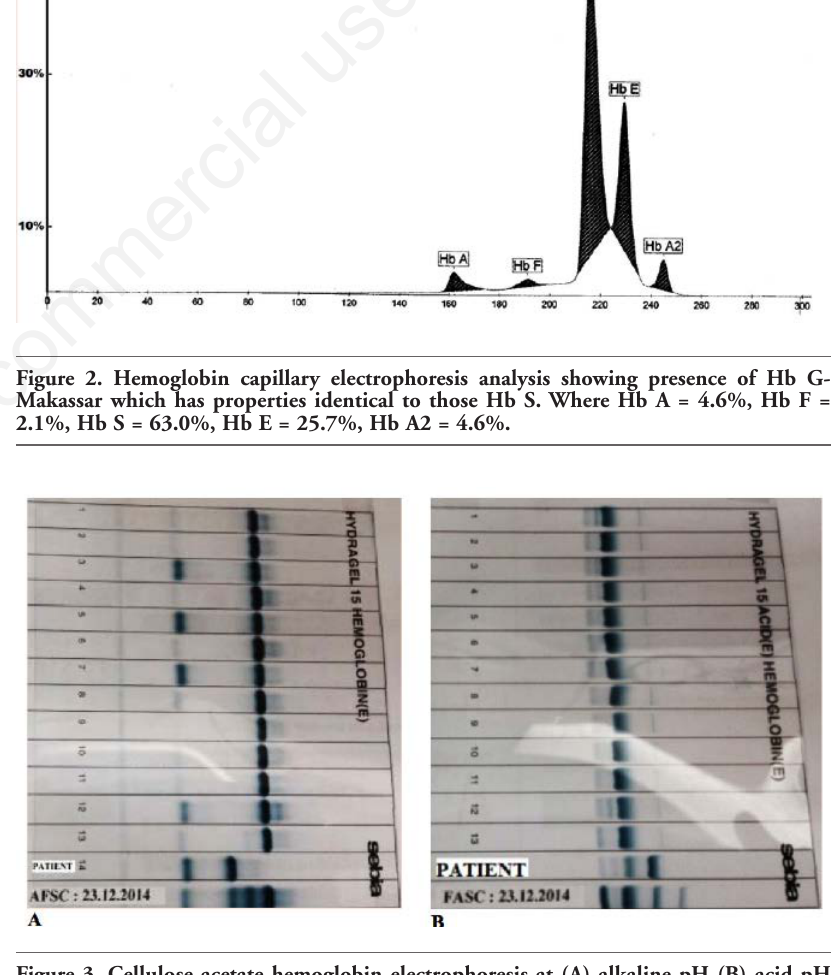
Figure 3. Cellulose acetate hemoglobin electrophoresis at (A) alkaline pH (B) acid pH show presence of Hb